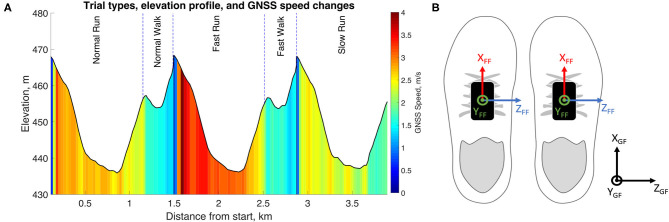
(A) The elevation and speed of the running circuit. This figure was adapted from Soltani et al. (2019). (B) The definition of the foot functional frame (FF) and global frame (GF) used in this study.